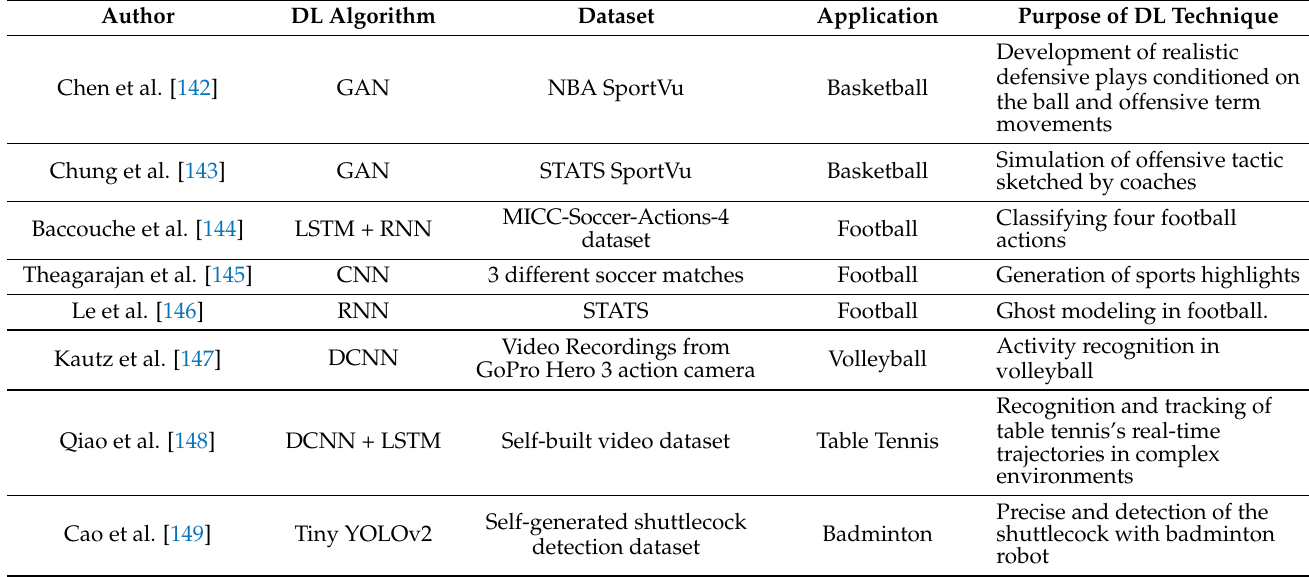
Table 9. State-of-the-art contributions in DL-based sports industry.